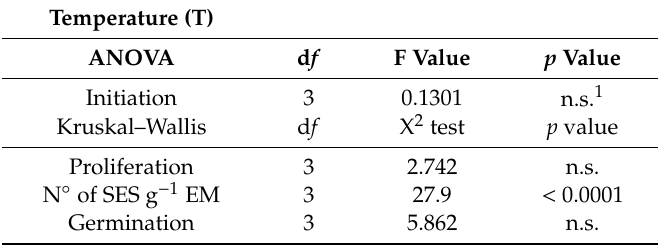
Table 1. One-way analysis of variance for initiation, proliferation, number of somatic embryos (SES) produced per gram of embryonal mass, and germination of Pinus halepensis megagametophytes